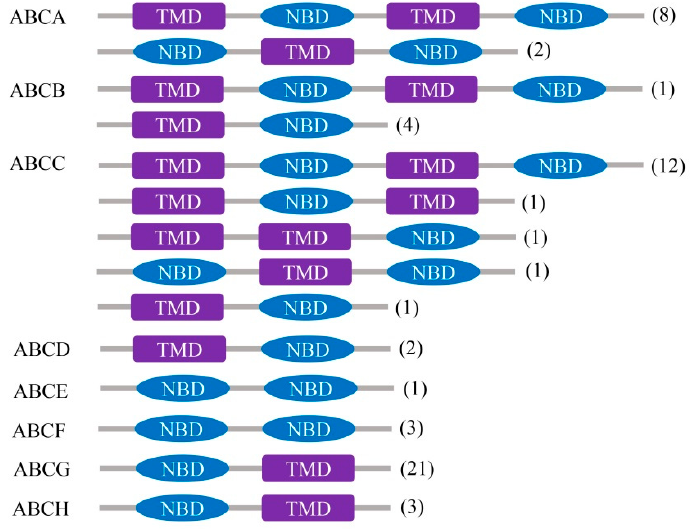
Figure 1. Conserved domains of A. sinensis ABC transporters. Gray bars represent the amino acid sequences of each structure type of ABC transporter genes. The subfamily names of the ABC transporters are marked on the left side of the structure types, and the gene numbers of each structure type are denoted in brackes on the right side of the gray bars. The purple-filled rectangular boxes denote transmembrane domain (TMD) positions on the amino acid sequences, and the blue-filled oval boxes indicate nucleotide binding domain (NBD) positions. The TMD and NBD domains of each A. sinensis ABC transporter were identified using the program Pfam.